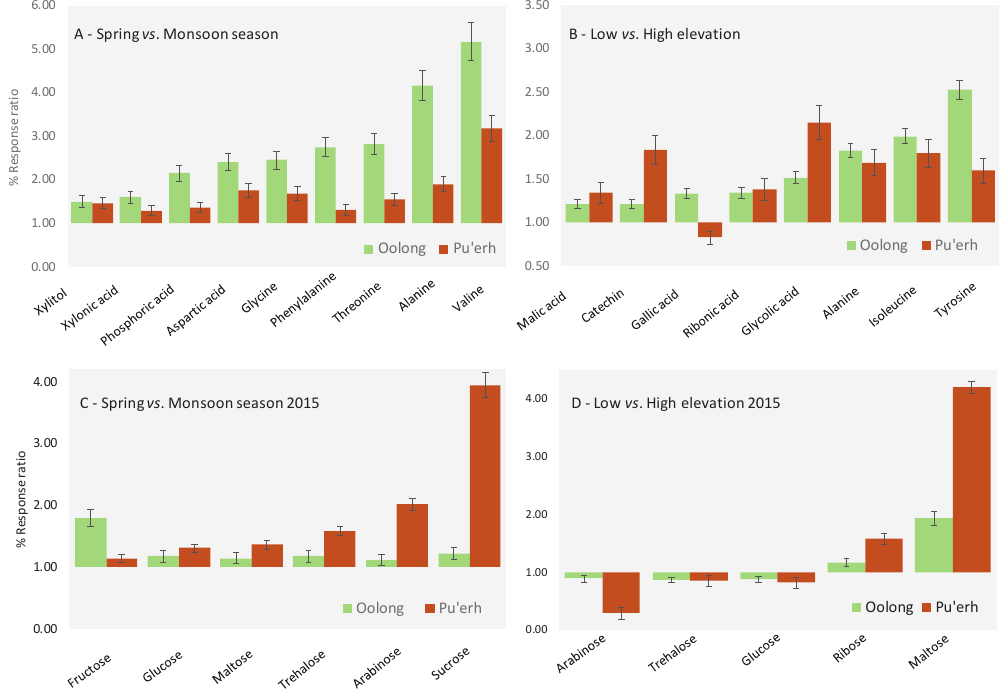
Figure 5. Histograms illustrating the % response ratio between the spring vs. monsoon season ( A ) and low vs. high elevation ( B ) teas. Error bars correspond to ± SD over all samples belonging to the same class. The sugar class is examined independently and results visualized in Figure ( C ) and ( D ) for seasonal and elevation effects respectively.